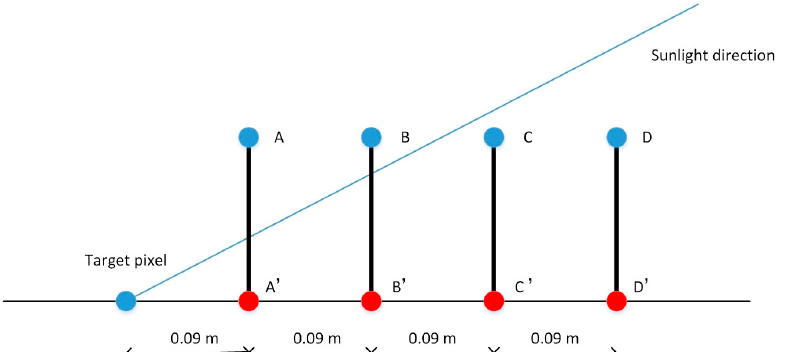
Figure 12. The principle of the geometric shadow detection process.